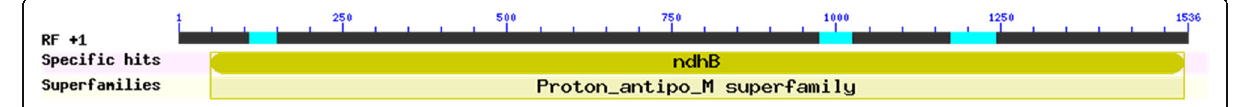
Fig. 2 Protein domains of the deduced amino acid sequence of the obtained ndhB protein